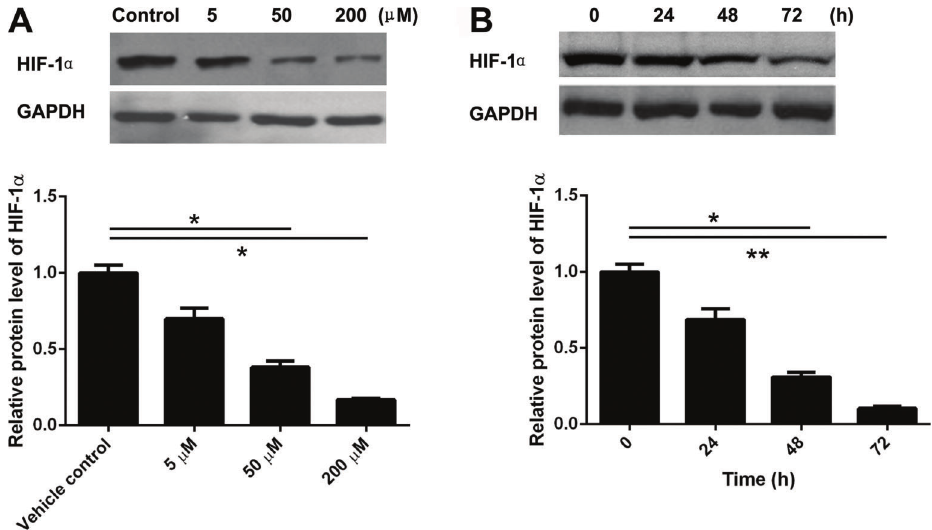
Figure 2. A , Hemangioma cells treated with different concentrations of propranolol for 48 h. B , Hemangioma cells treated with 50 m M propranolol for 24, 48, and 72 h. The expression of hypoxia inducible factor-1 a (HIF-1 a ) protein level was determined by western blotting. Data are reported as means ± SD absorbance of HIF-1 a protein of three independent experiments. *P o 0.05, **P o 0.01 (ANOVA).